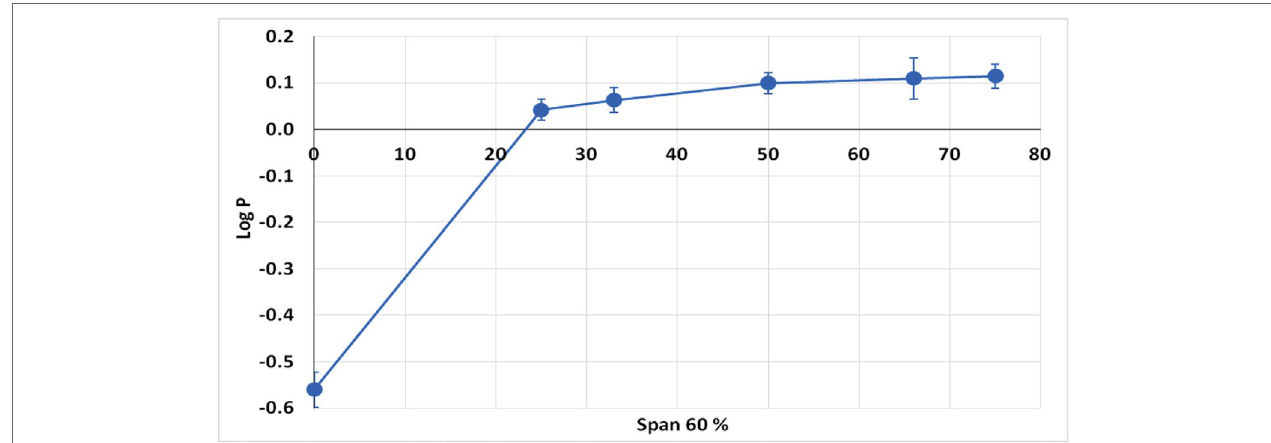
FIGURE 5 | Partition coefficient of metformin HCl and its encapsulated form in Span